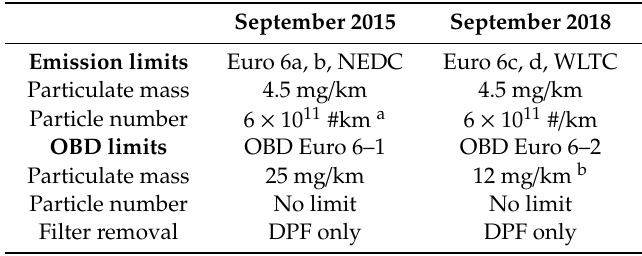
Table 1. European Union (EU) legislation limits and implementation dates for the first registration of vehicles.